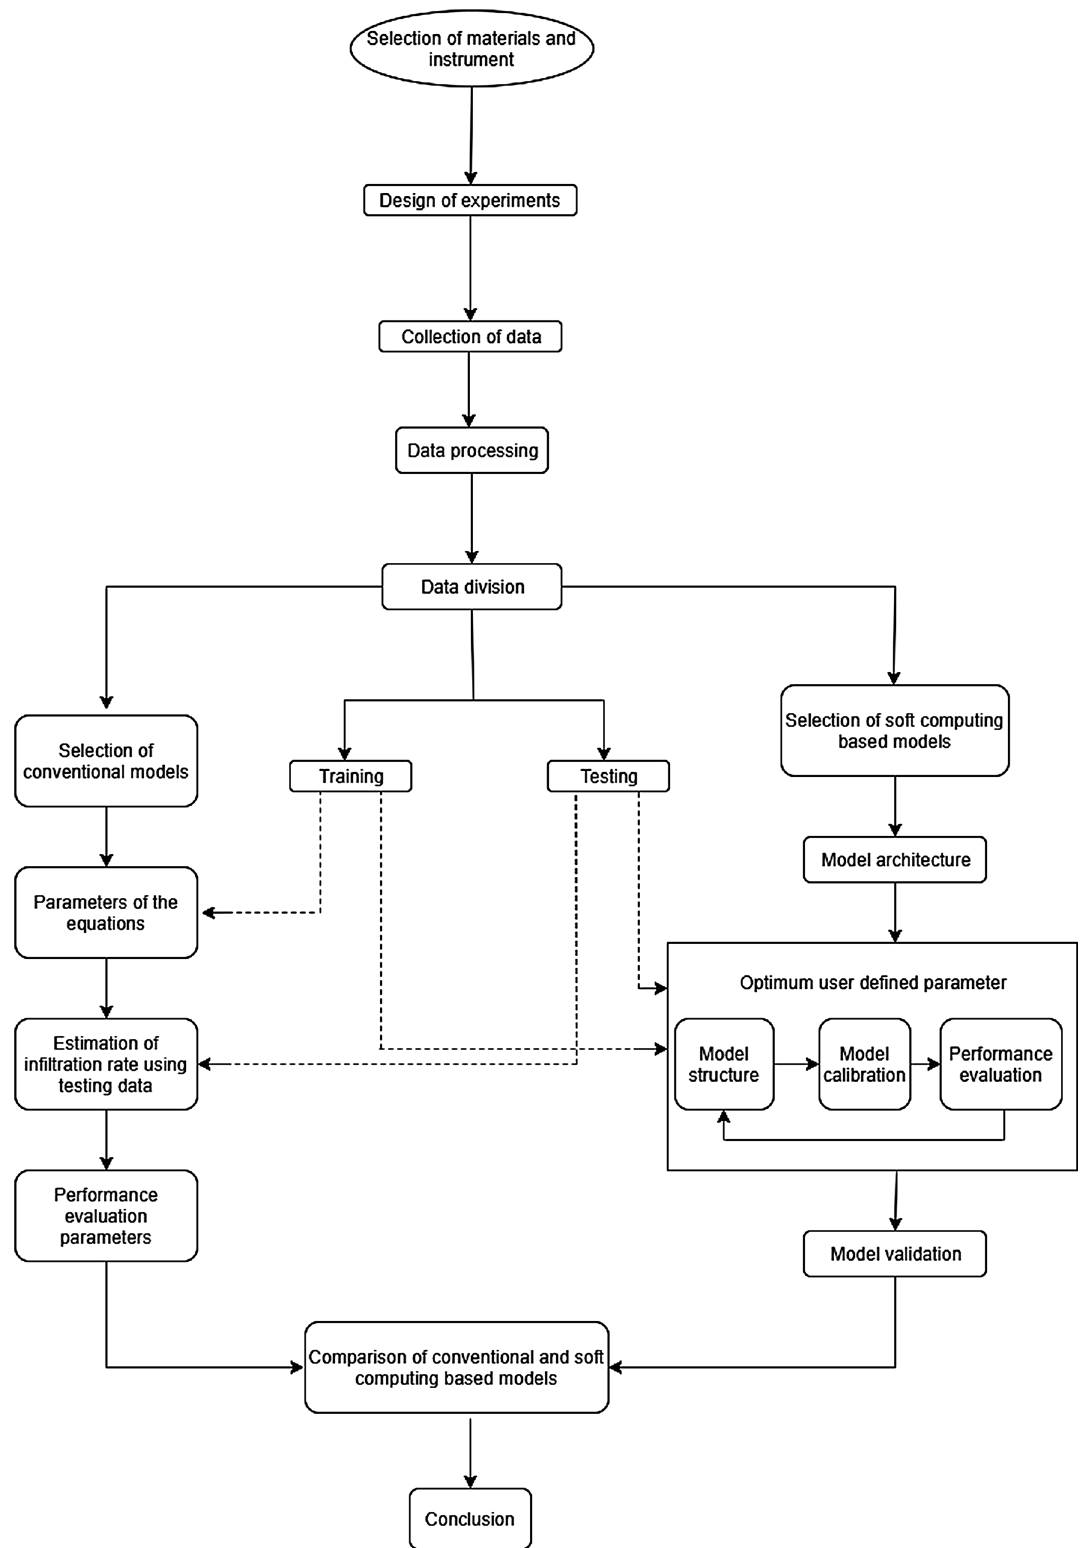
Fig. 2 Flowchart of the